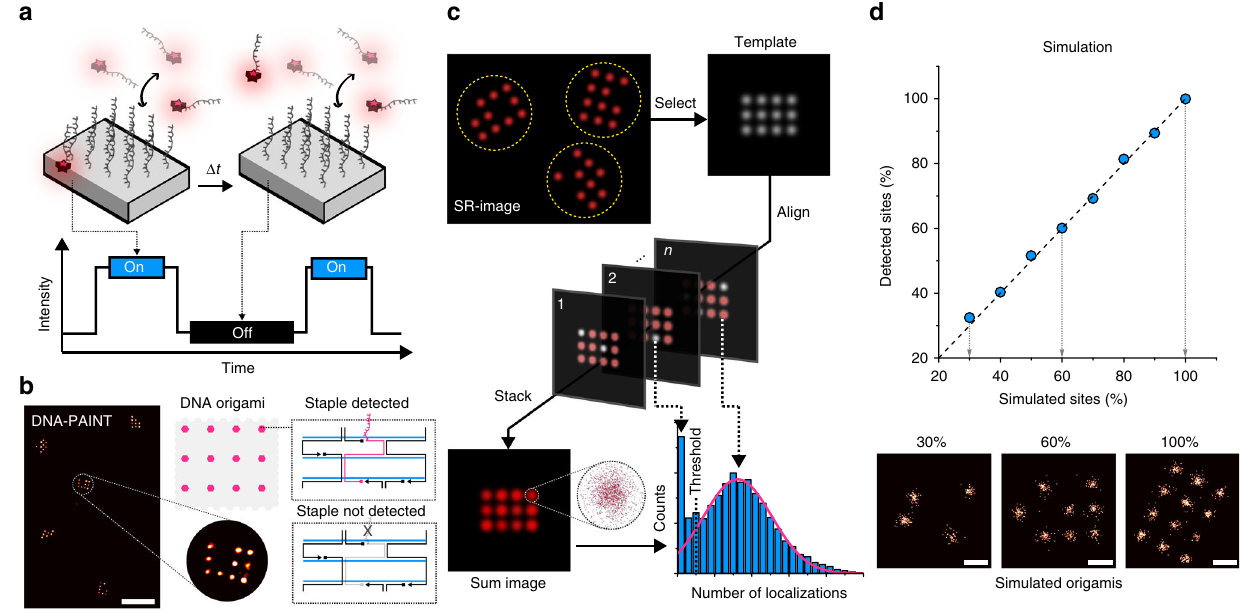
Fig. 1 Quanti fi cation of detected staples in DNA origami using super-resolution. a DNA-PAINT concept: transient hybridization of dye-labeled imager strands to docking sites on DNA origami enables super-resolution imaging. b Typical DNA-PAINT image of 20-nm-grids allows distinction of individual binding sites. Zoom-in of a 20-nm-grid shows that some of the 12 grid sites were not detected. c Quanti fi cation work fl ow for assessing abundance of docking sites. Single structures were selected and aligned to a template of the designed grid structure by image cross-correlation. Subsequently, a histogram of localizations per grid site was used to determine a cut-off threshold below, which a site is de fi ned as not detected. This threshold is de fi ned as the number of localizations at half-maximum as determined by the Gaussian fi t (magenta curve). d Benchmarking of the detection work fl ow was performed using simulated ground-truth DNA-PAINT data. Blue dots represent simulated 20-nm-grids with varying percentage of simulated docking sites and their evaluation result. The dashed line is the identity line. Scale bars: 100 nm in b , 20 nm in strands surrounding the biotinylated strands for surface attach- ment (white hexagons in Fig. 4c), as staple orientation and routing at these locations are inconsistent with the standard design of the rectangle. We then quanti fi ed the accessibility for all 168 staples and constructed a heatmap of the rectangle displaying the accessibility as a function of docking-site position (Fig. 4c). The results indicate a consistently lower ef fi ciency of detection on the outside of the structure (with a minimum of 41%) compared to inner areas where detection ef fi ciencies reached 88% (the average detection ef fi ciency for all strands was 77%). Taking the detection ef fi ciency offset of 7% determined by the results from Fig. 2, this translates to absolute incorporation ef fi ciencies of 48 – 95% with an average of 84%, in good agreement with quali- tative results of relative staple abundance from next-generation sequencing 26 . A heatmap displaying the translated values of absolute incorporation ef fi ciencies is shown in Supplementary Fig. 14. To further evaluate our assumption that we can directly translate the detection ef fi ciency offset from Fig. 2 to strand incorporation and eliminate possible accessibility effects, we targeted a single-stranded section of the scaffold strand (Supplementary Fig. 16a) on the edge of the 2D rectangular origami (scaffold loop). The assumption was that this scaffold loop must be present in every structure. We detected the scaffold loop in 90% of all cases. To further investigate the effect of potential surface interaction, we used a three-dimensional DNA origami structure, the force clamp 27 . This structure spans a section of the scaffold strand between two pillars more than 20 nm above the surface. Here, we mimicked the single-stranded scaffold loop we targeted in the 2D rectangular origami (Supplementary Fig. 16b) and found a 91% detection ef fi ciency, indicating that there is no signi fi cant effect arising from surface interactions. We additionally used the force-clamp structure to